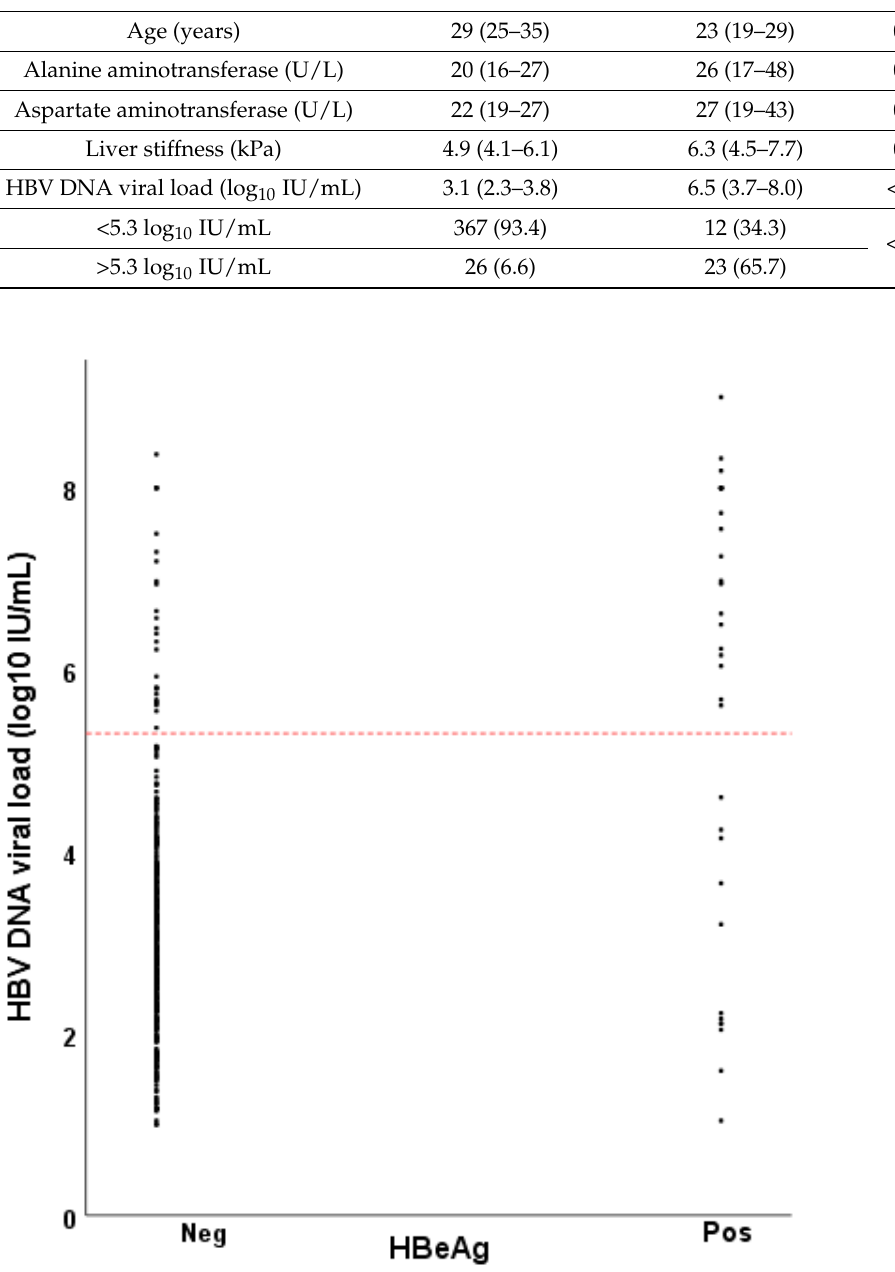
Figure 1. Hepatitis B virus (HBV) DNA viral load as a function of HBeAg status among women of childbearing age with chronic hepatitis B in Ethiopia. The reference line at 5.3 log 10 IU/mL (200,000 IU/mL) indicates the threshold for high risk of vertical transmission of hepatitis B virus.